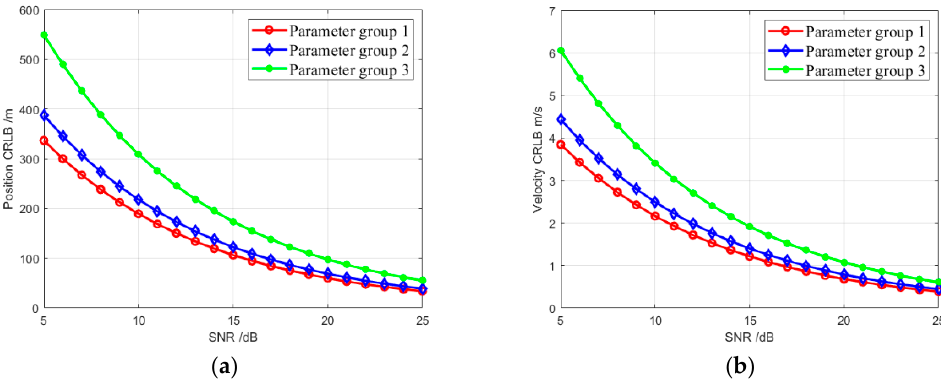
Figure 3. CRLB of the joint localization and velocity estimation. ( a ) Position CRLB versus the echoes’ SNR. ( b ) Velocity CRLB versus the echoes’ SNR.